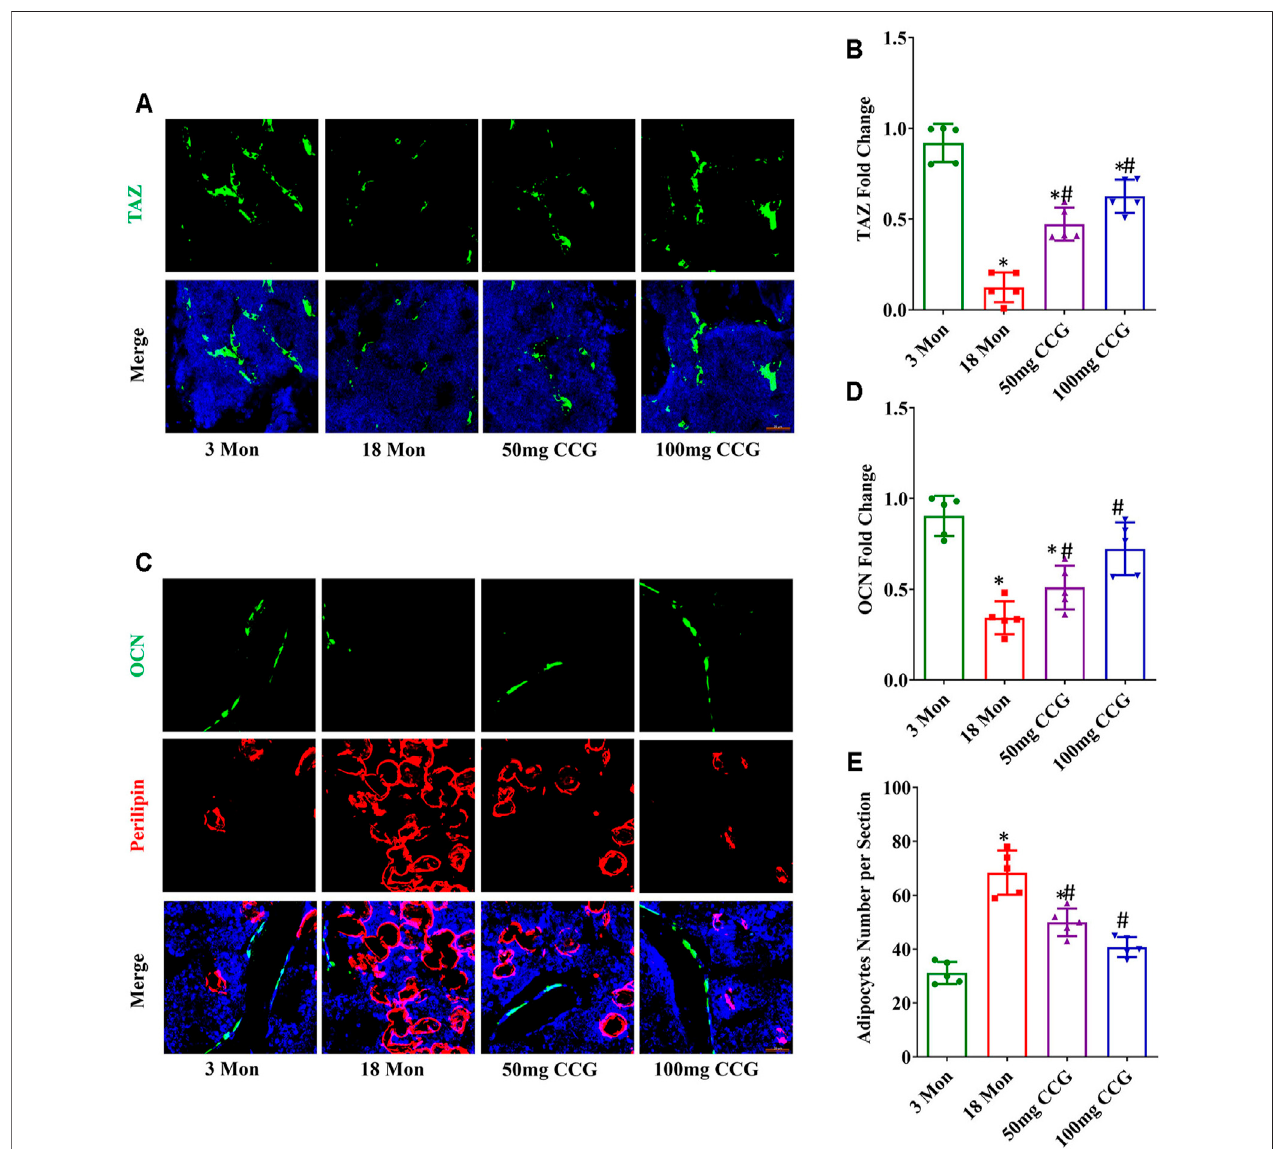
FIGURE2| CCGtargetedTAZtoregulate theswitchfrom adipogenesistoosteogenesisofBMSCs invivo . (A,B) Representativeimagesand quantitativeanalysis of TAZ (green) expression in the mice femurs from different groups. (C – E) Immuno fl uorescent staining of OCN (green) and perilipin (red) in the mice femurs and the relevant quantitative analysis. Scale bar: 50 μ m (n (cid:1) 5) * p < 0.05 vs. the 3-mon mice group; # p < 0.05 vs. the 18-mon mice group.